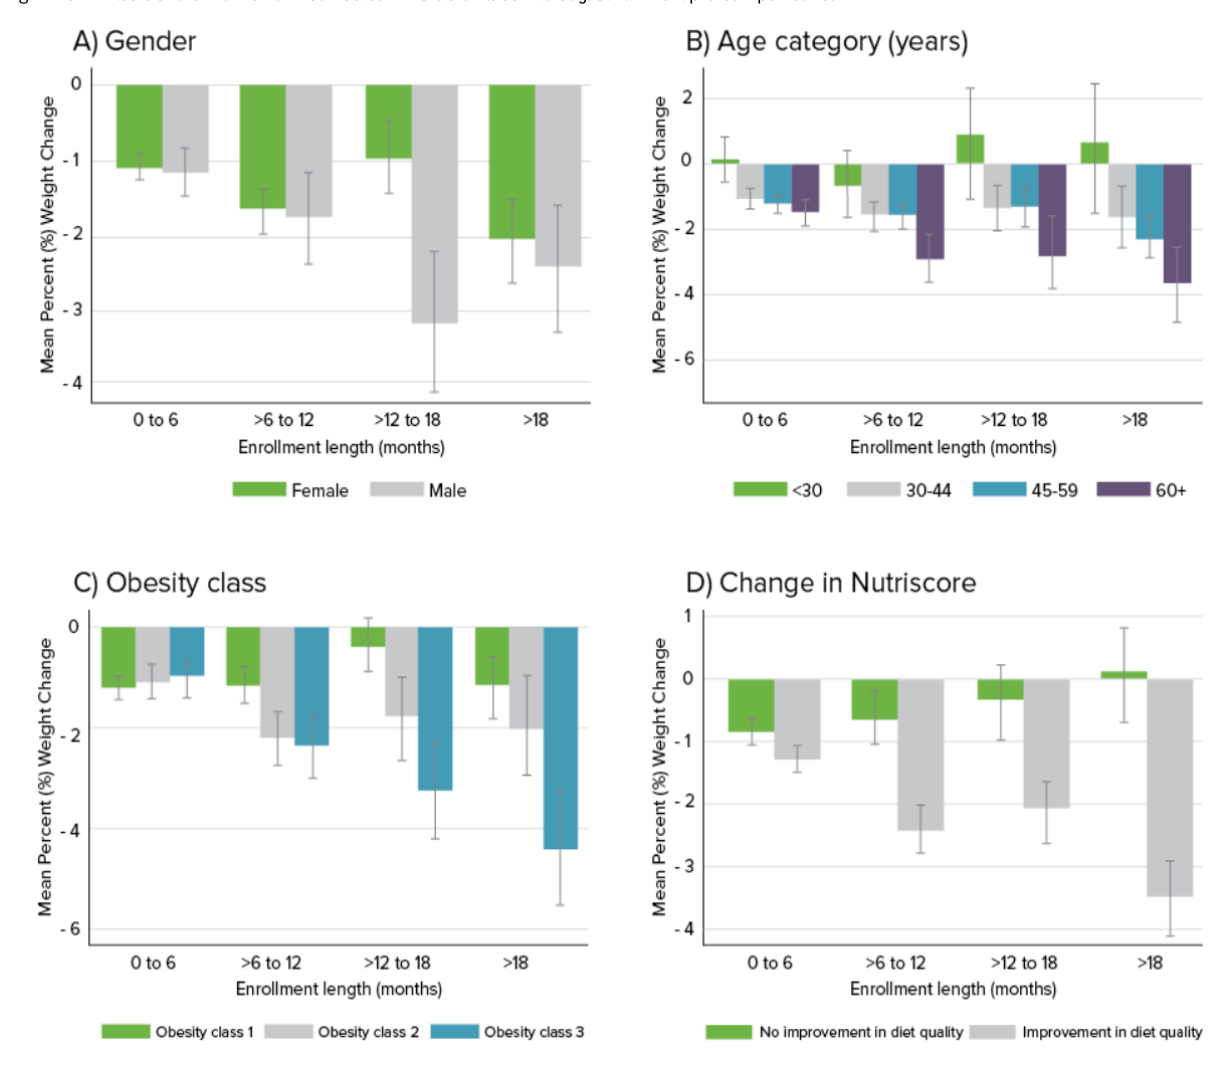
Figure 3. Mean (SD) percent weight change stratified by enrollment length and A) gender, B) age category, C) baseline obesity class, and D) change in Healthy Diet Score. Gray error bars indicate standard deviations of the mean; * indicates a statistically significant difference between groups